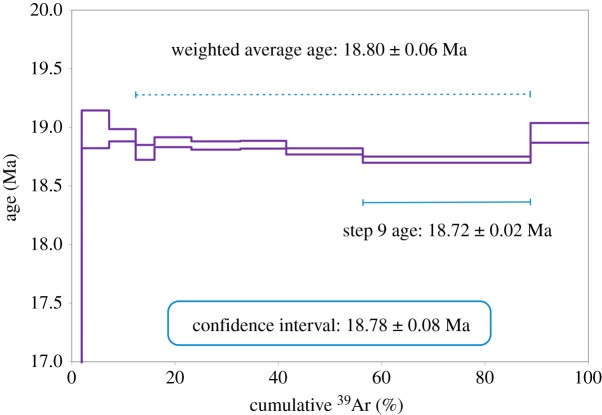
40Ar/39Ar age spectrum of the biotite separate of the tephra layer CHILC-AT1. The most conservative age assignment, taking into account interpretive ambiguities at the 0.4% level, is 18.78 ± 0.08 Ma. All uncertainties are shown as 2σ.